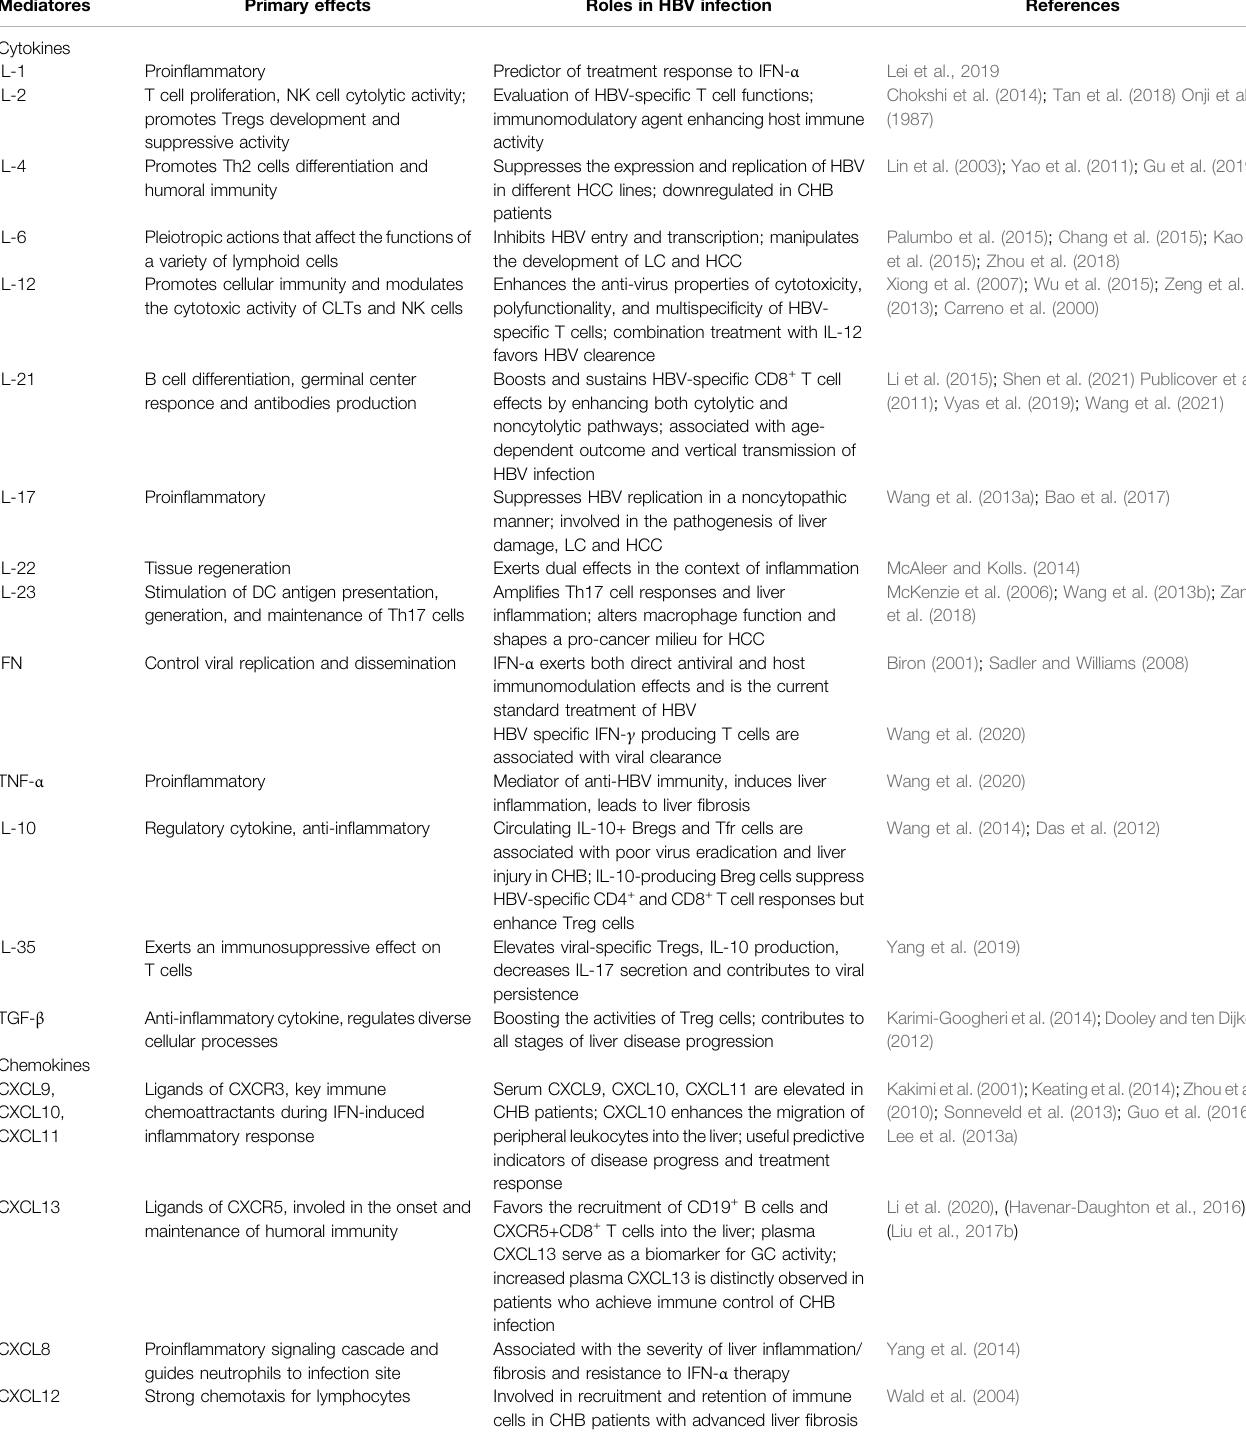
TABLE 1 | Important cytokines and chemokines in HBV